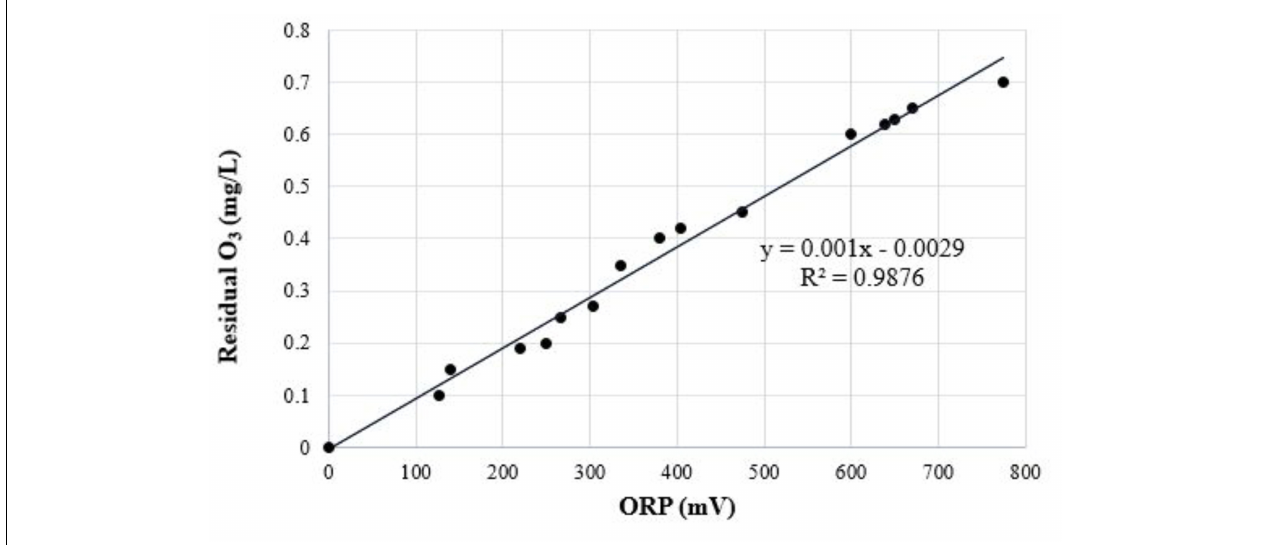
FIGURE 1 | Plot of the mean dissolved ozone concentrations vs. mean oxidative reduction potential (ORP) measurements that were logged at the end of the ozone contact chamber. A linear regression shows the relationship between dissolved ozone and ORP.